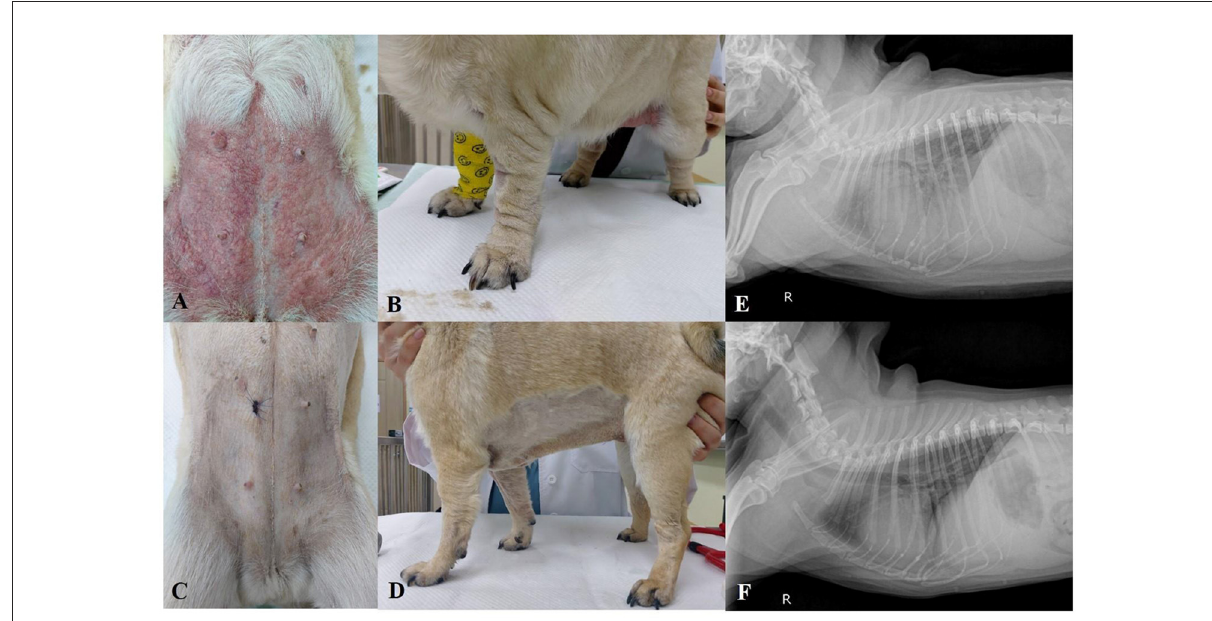
FIGURE1 Photographs of the skin condition of Case 1. (A,B) Severe systemic erythema, edema, and urticaria at presentation. (C,D) One week after treatment initiation, erythema and edema disappeared. (E) Pulmonary interstitial infiltration and right-side cardiomegaly at the presentation on X-ray. (F) One week later, after treatment initiation, the infiltration of the lung